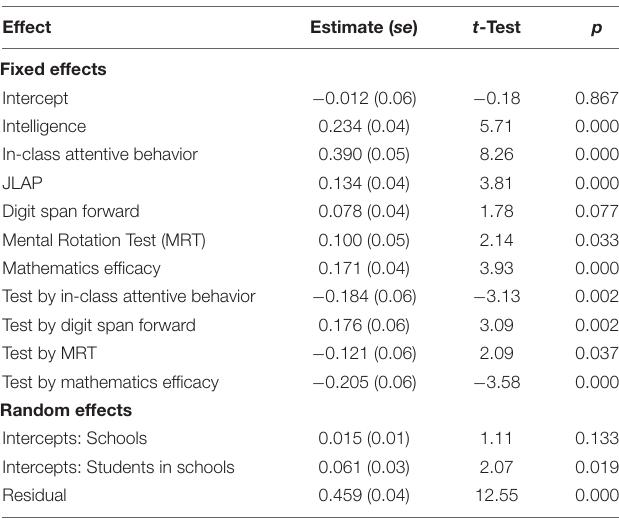
TABLE 5 | Estimates from multi-level model for Oral Reading Accuracy and Numerical